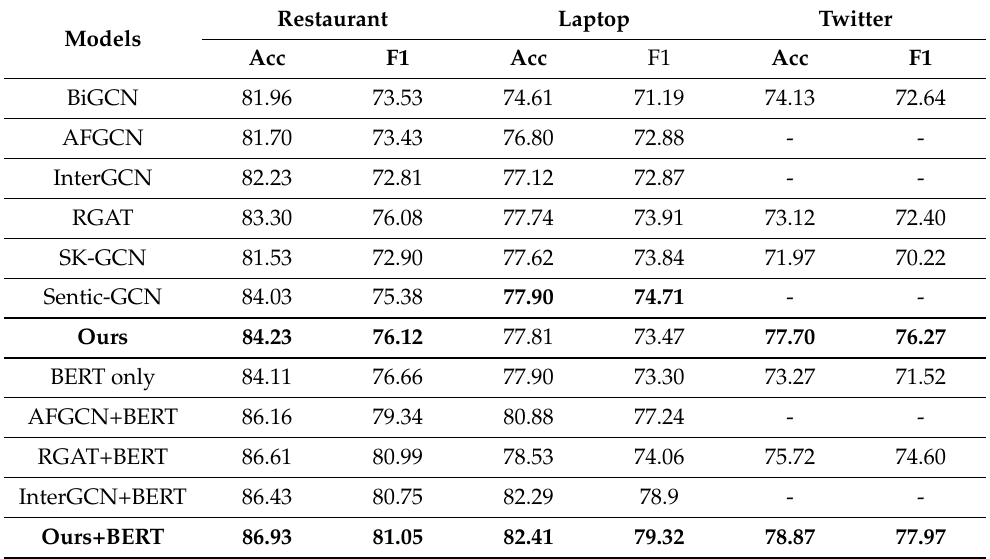
Table 2. Experimental